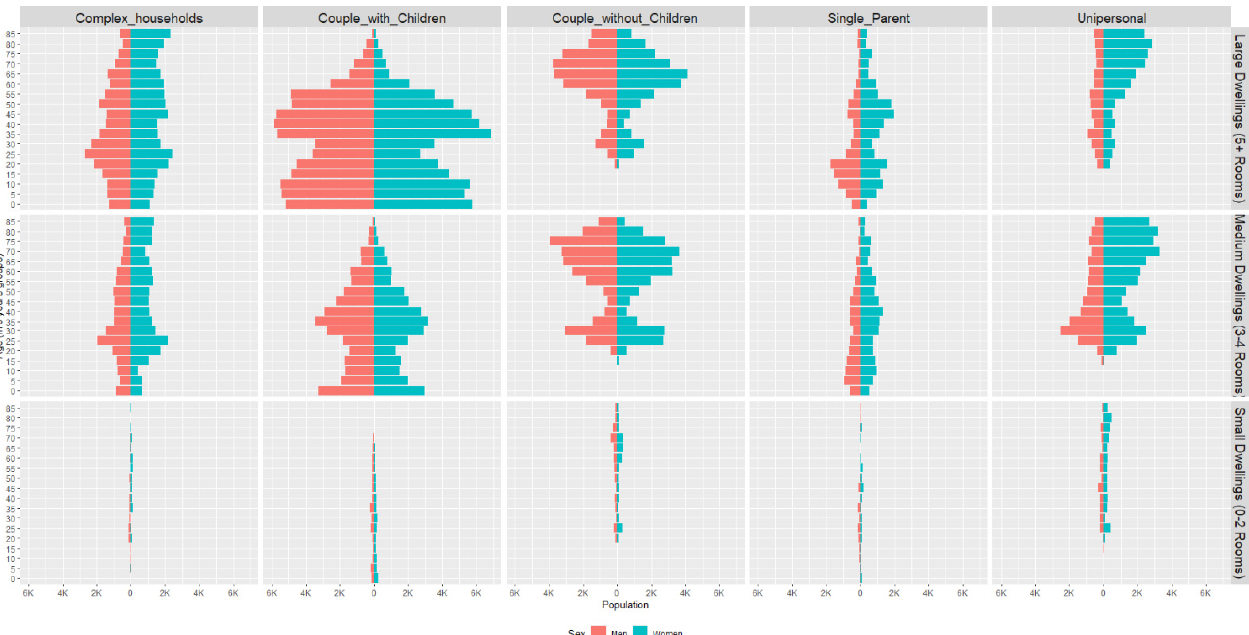
Figure 5. Relationship between the size of dwellings and household type, 2011. Source: Own elaboration, with data from Census records 2011.